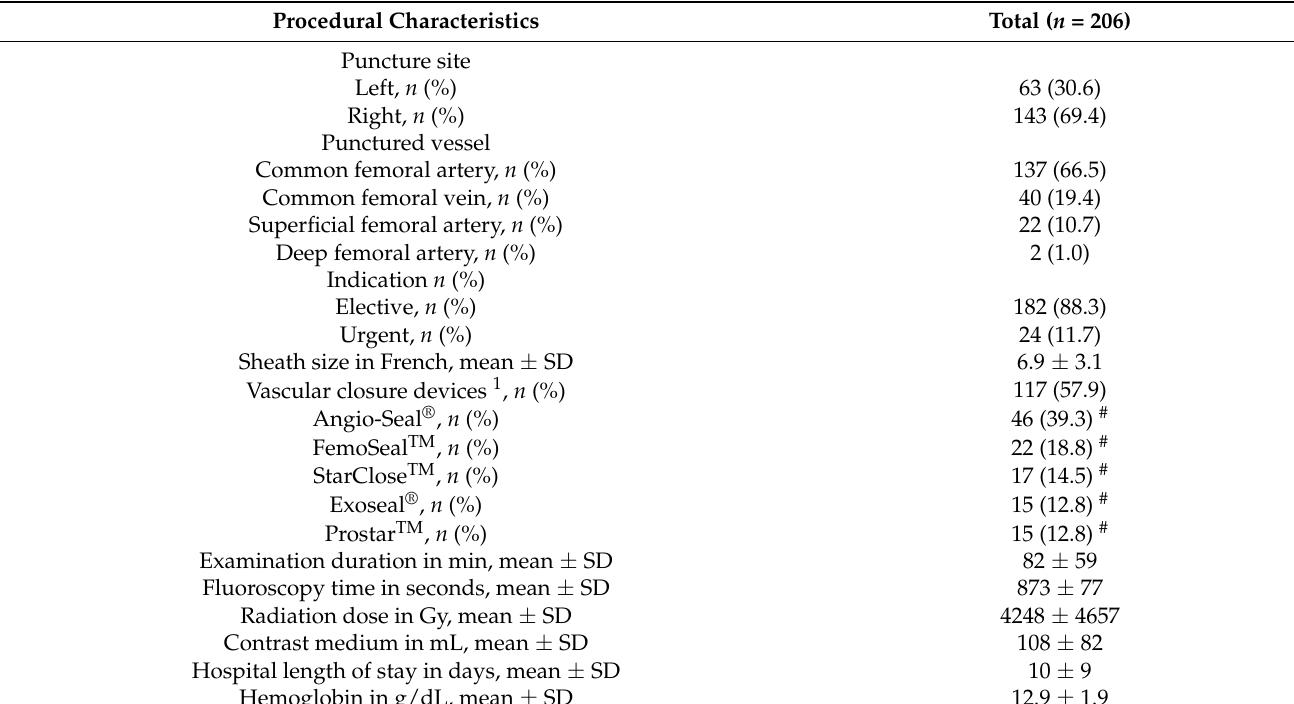
Table 3. Procedural characteristics of patients with access site